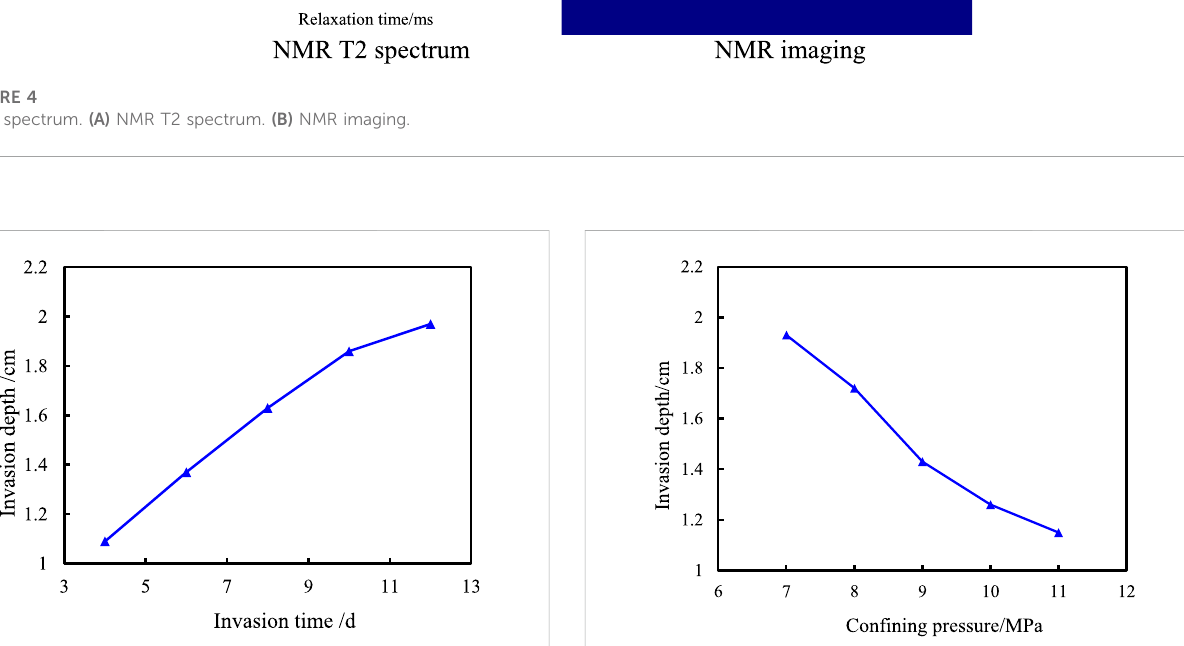
FIGURE 5 Invasion depth of the drilling fl uid at different invasion times.